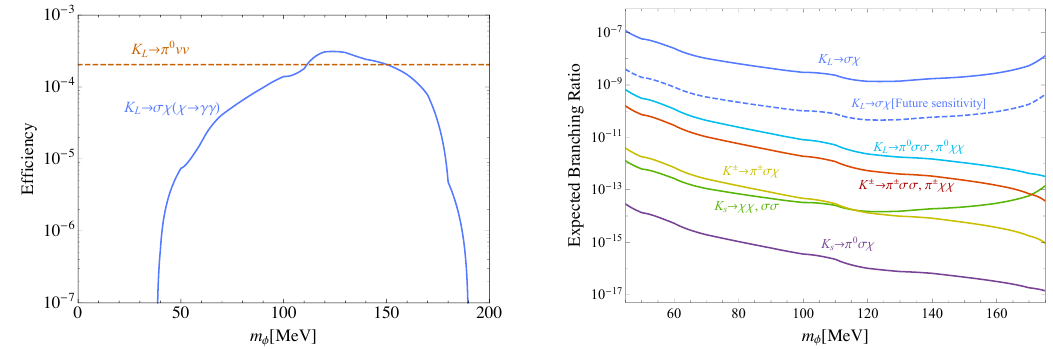
Figure 12 . Left panel: signal e(cid:14)ciency as a function of the (cid:31) mass (blue curve). In the plot, we (cid:12)x m (cid:31) = m (cid:27) . For comparison, we show in red the KOTO e(cid:14)ciency for the K L ! (cid:25) 0 (cid:23) (cid:22) (cid:23) signal. Right panel: the blue lines represent the BR( K L ! (cid:27)(cid:31) ) needed to produce 3 events in the KOTO signal region using the data collected in 2016-2018 (solid line), or future KOTO data (dashed blue). The other curves correspond to the predictions for BR( K L ! (cid:25) 0 (cid:27)(cid:27) ) and BR( K L ! (cid:25) 0 (cid:31)(cid:31) ) (light blue), BR( K (cid:6) ! (cid:25) (cid:6) (cid:27)(cid:27) ) and BR( K (cid:6) ! (cid:25) (cid:6) (cid:31)(cid:31) )(red), BR( K (cid:6) ! (cid:25) (cid:6) (cid:27)(cid:31) ) (yellow), BR( K S ! (cid:27)(cid:27) ) and BR( K S ! (cid:31)(cid:31) ) (green), and BR( K S ! (cid:25) 0 (cid:27)(cid:31) ) (purple), once we demand the model to produce 3 events in the KOTO signal region using the data collected in 2016-2018. For the latter three curves, we have (cid:12)xed y 2 = 2 y 1